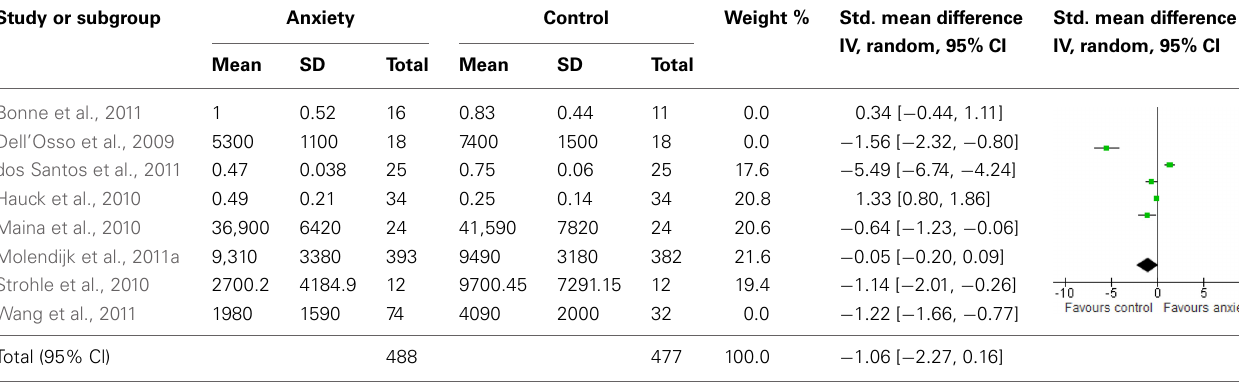
Table 4 | Sensitivity analysis: studies using serum. Study or